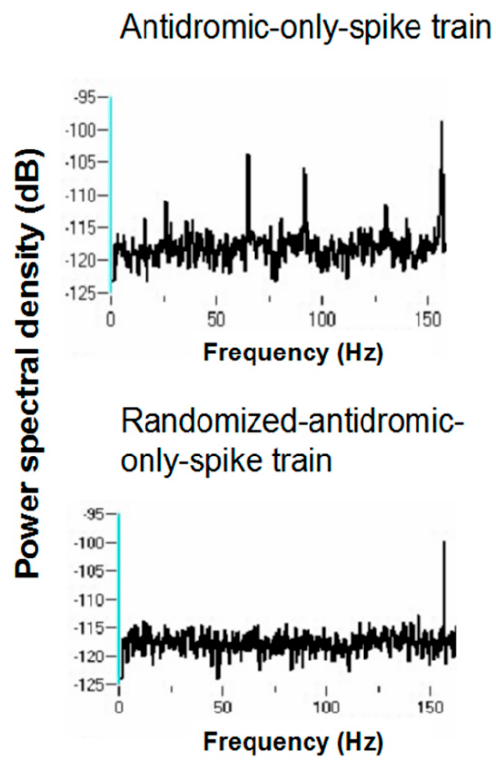
Figure 18. Representative power spectral density of a antidromic-only spike train and its randomized-only spike train counterpart for 160 pps DBS.